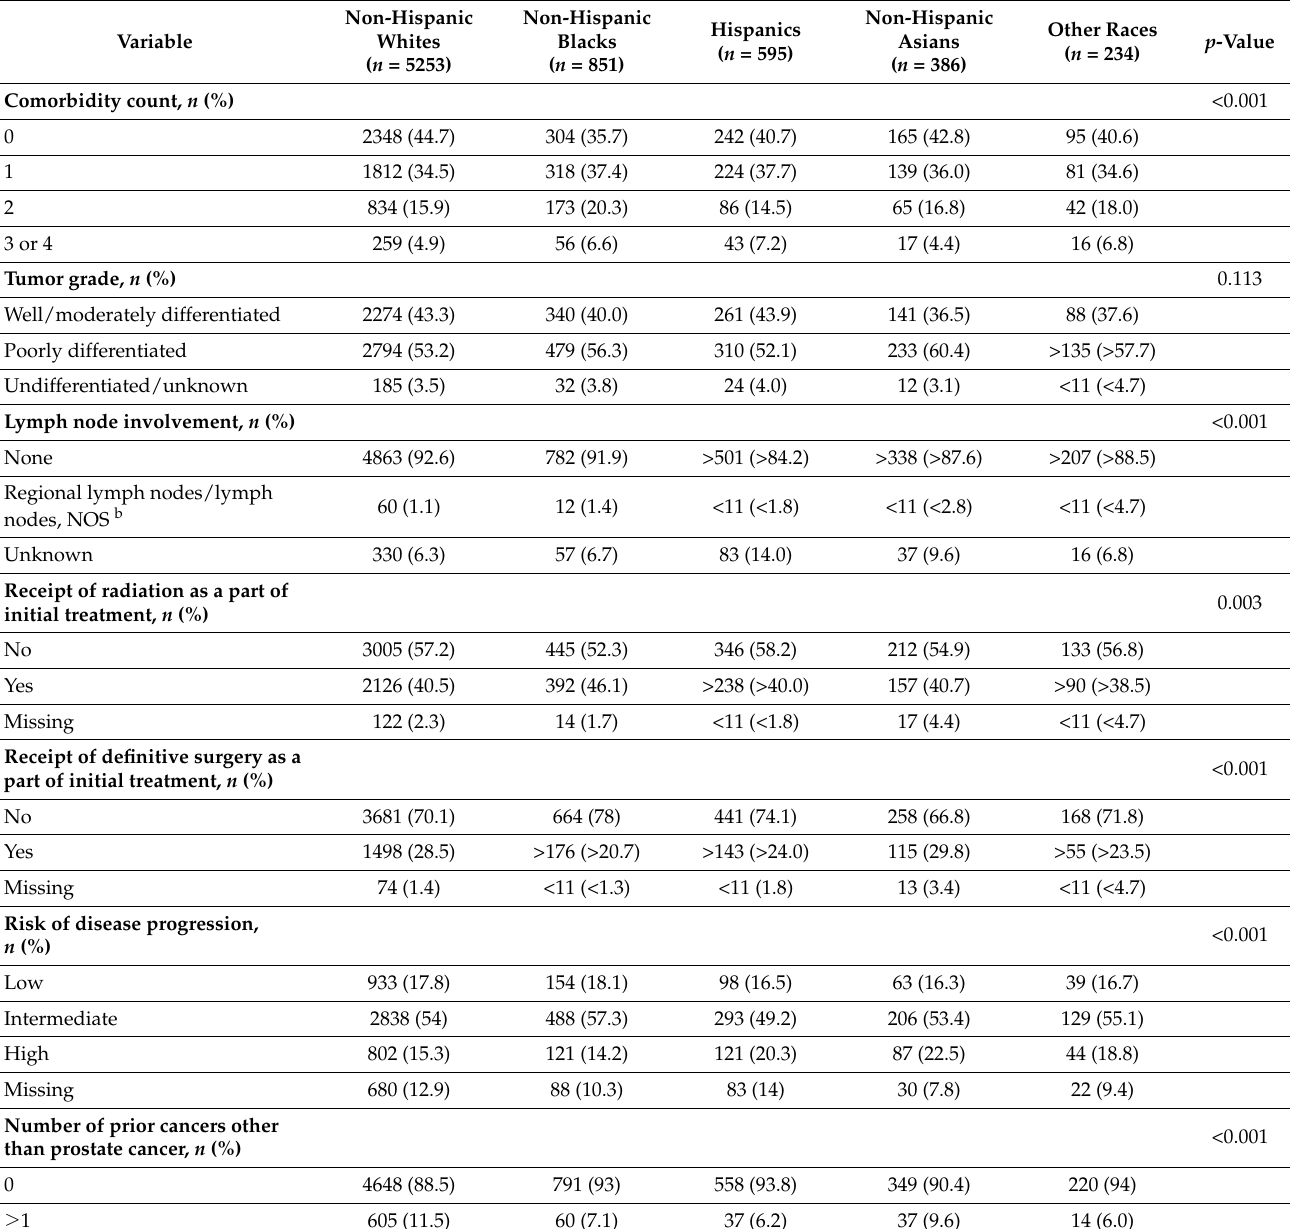
Table 2. Clinical characteristics of study cohort by race/ethnicity a